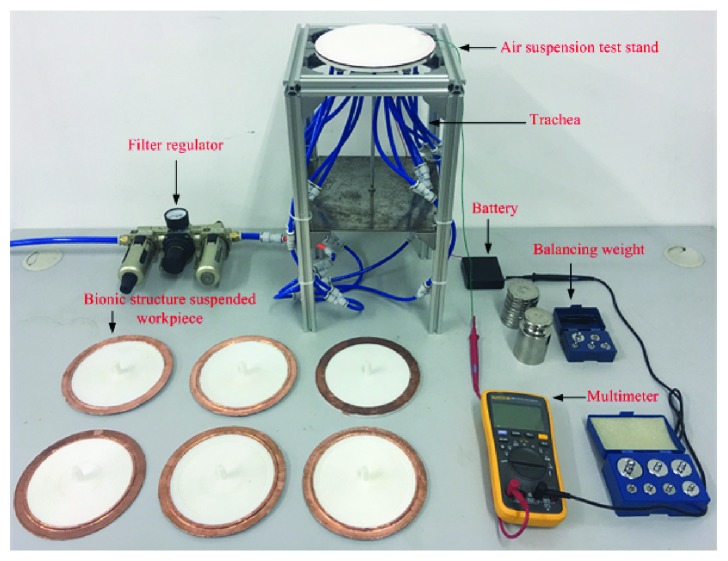
Suspended workpiece.